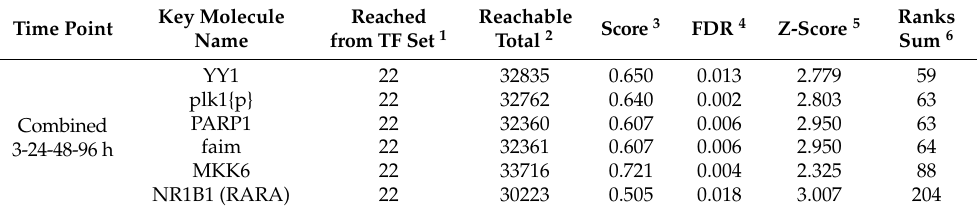
Table 2. Putative key molecules that regulate DEPs at 3, 24, 48, and 96 h during ATRA-induced differentiation of HL-60